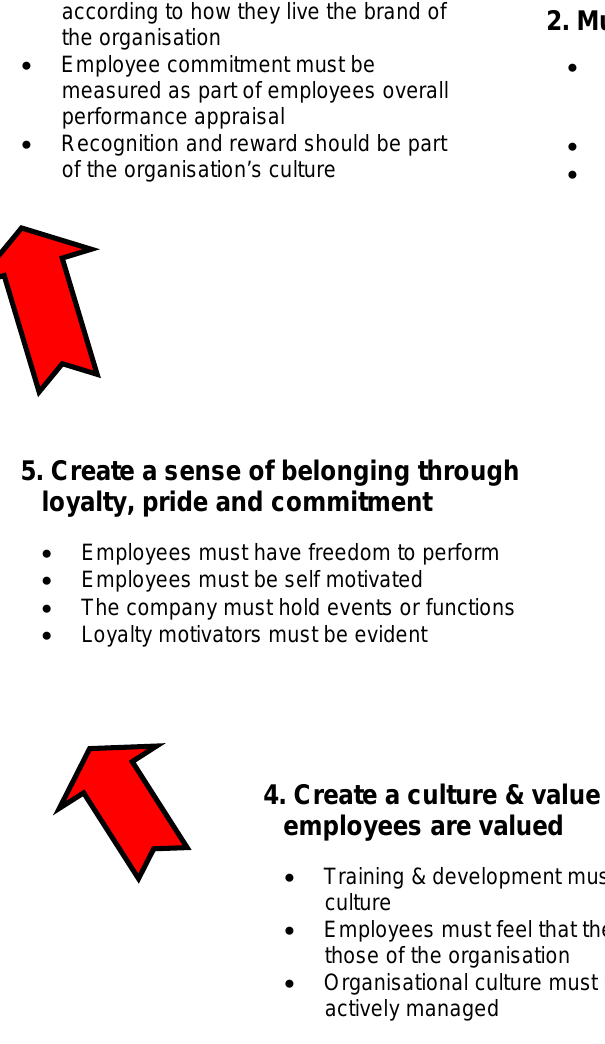
Figure 1: Employee branding model: A self reinforcing